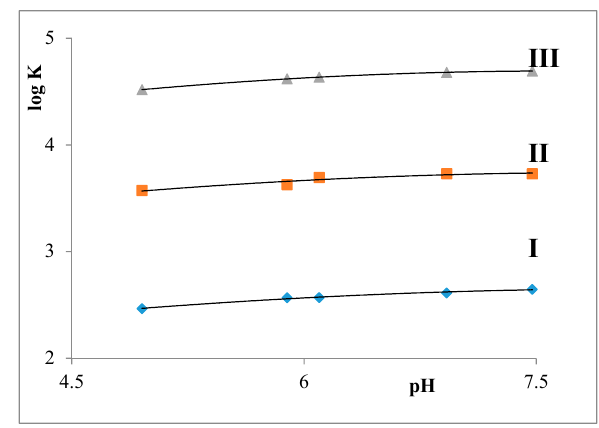
Figure 5. Dependence of partition coefficient of surfactants on pH. I : C12, II : C14, and III : C16.